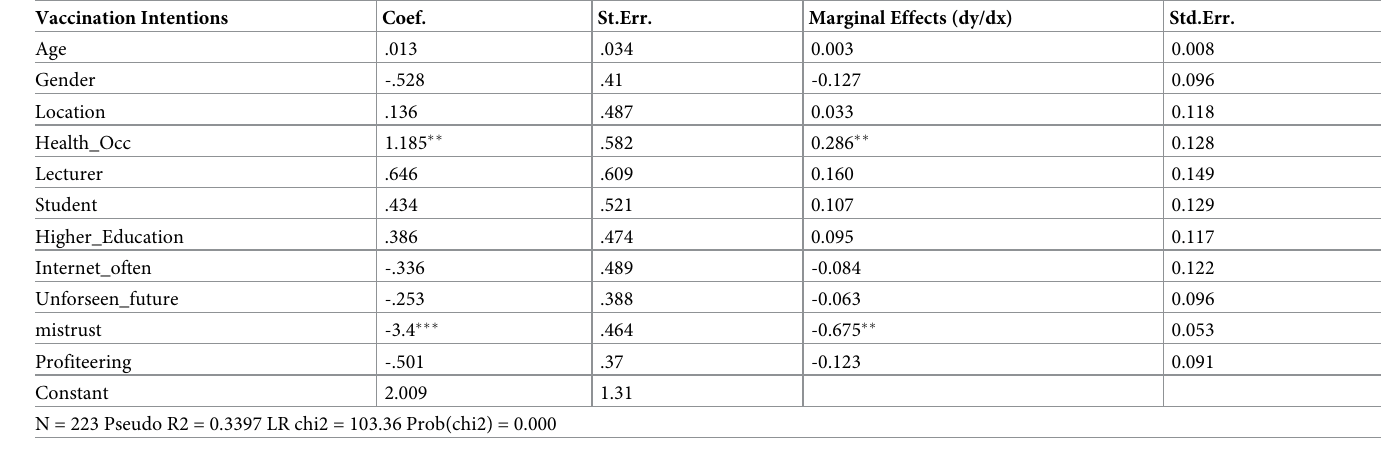
Table 7. Predictive effect of perceptions about fear of the unforeseen, mistrust of vaccine and concerns of profiteering on vaccination intentions. Vaccination